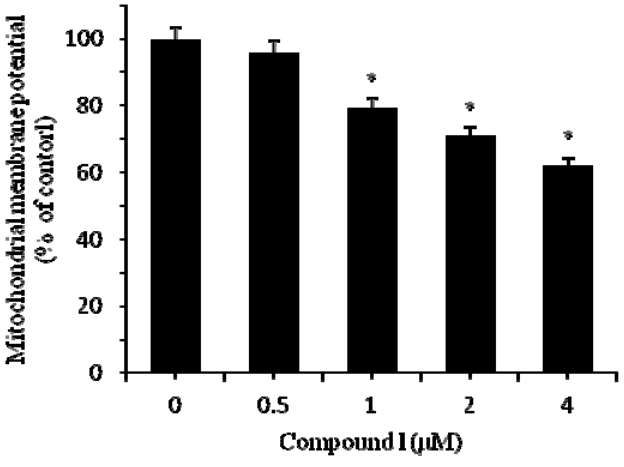
Figure 4. Mitochondrial membrane potential loss of HCT-8 cells treated by compound 1 at different concentrations for 24 h. Results are expressed as mean ± SD (n = 3). * p < 0.05, significantly different from the untreated group.